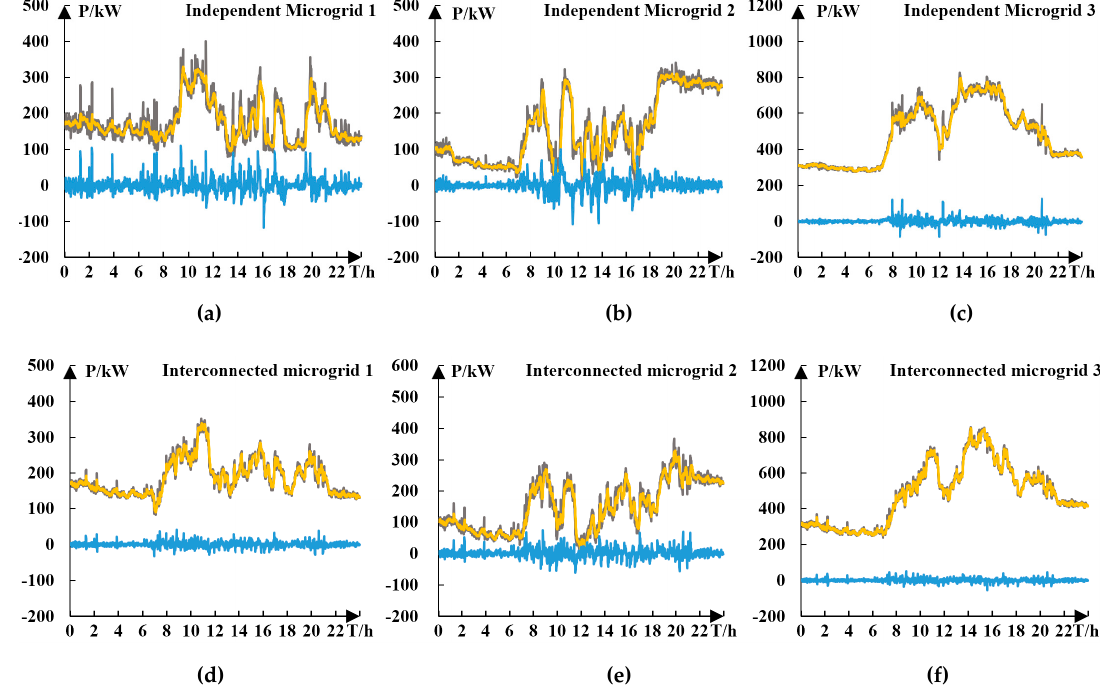
Figure 9. Microgrid original power (yellow line), expected power (grey line) and ESS power (blue line) curve based on Objective 1. ( a ) Results of independent microgrid 1. ( b ) Results of independent microgrid 2. ( c ) Results of independent microgrid 3. ( d ) Results of interconnected microgrid 1. ( e ) Results of interconnected microgrid 2. ( f ) Results of interconnected microgrid 3. Table 2. ESS capacity of independent microgrid scheme with Objective 1.